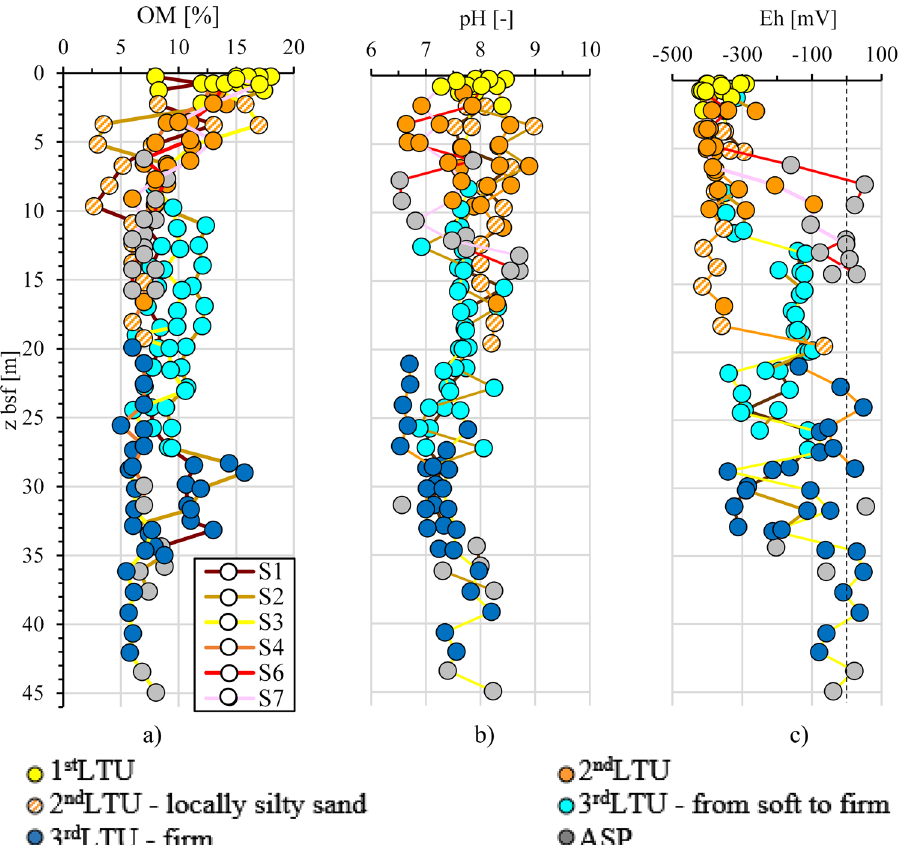
Figure 13. Profiles of physical properties of the samples collected at the B boreholes from different LTUs (sites S1, S2, S3, S4, S6, S7 close to section N–N ′ in Fig. 2): ( a ) organic matter OM; ( b ) pH; ( c ) redox potential Eh.